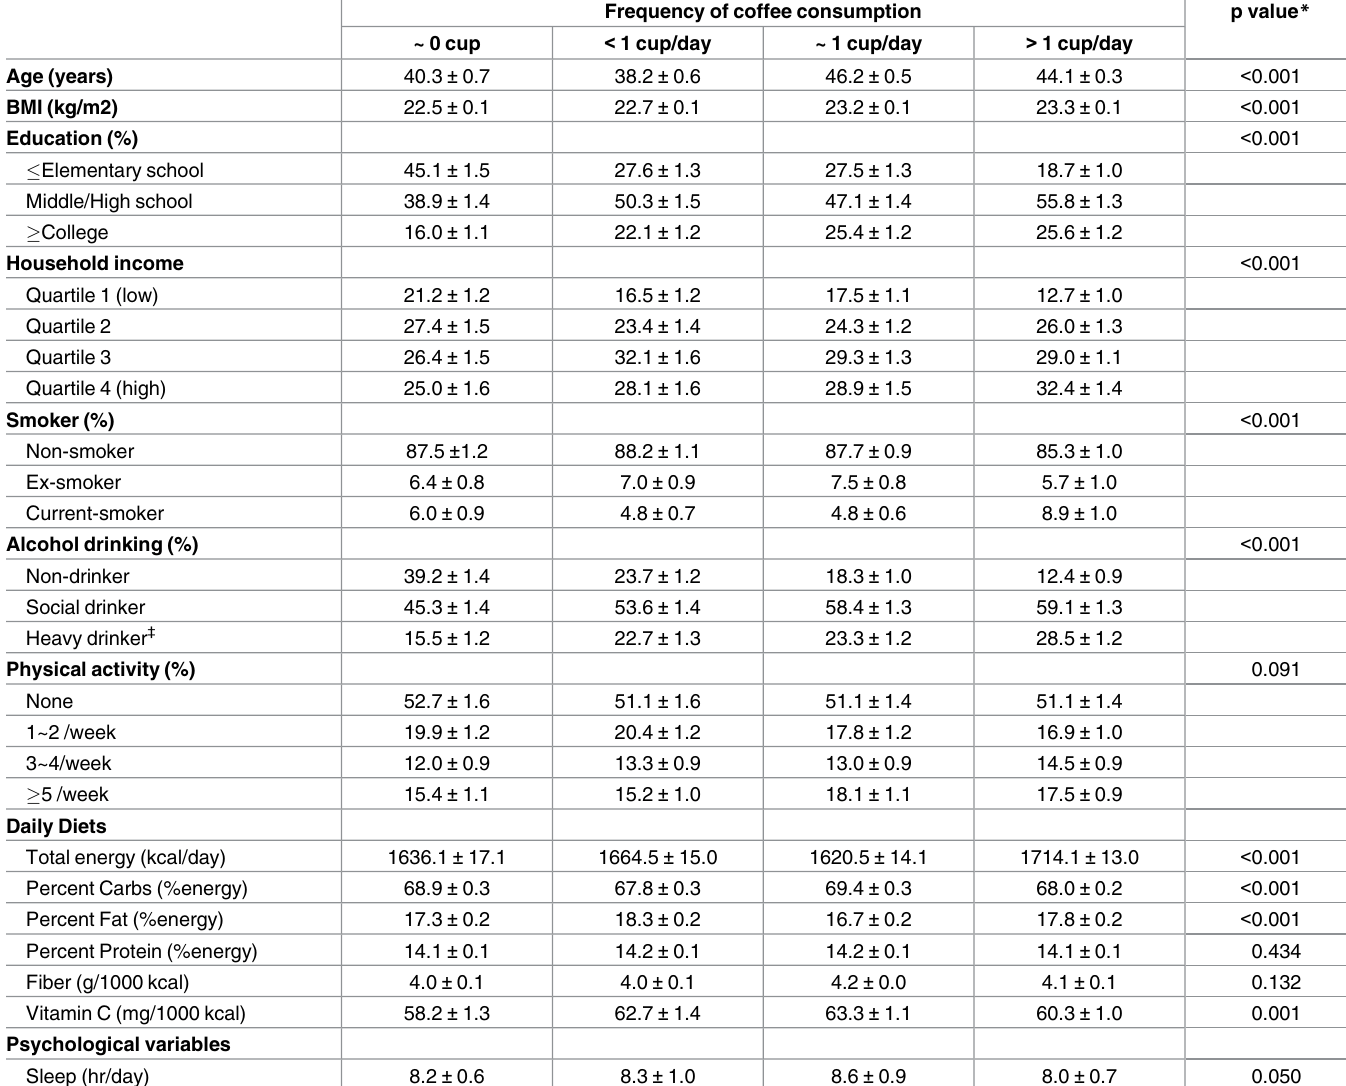
Table 1. Basic characteristics of study population by frequency of coffee